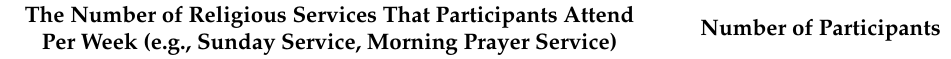
Table 3. Frequency of religious services attendance per week. The Number of Religious Services That Participants